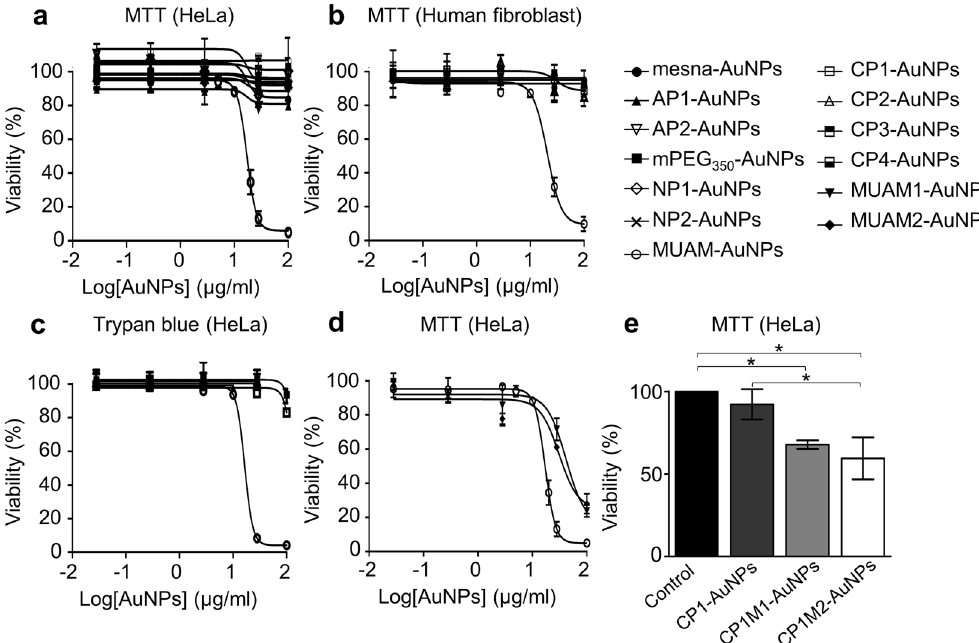
Figure 2. Effect of modified gold nanoparticles (AuNPs) on cell viability. ( a ) The viability of AuNPs-treated HeLa cells were analysed using MTT assays. Only MUAM-AuNPs induced cell death with LD 50 of 17.1 μ g/ml. ( b ) The viability of AuNPs-treated human fibroblasts were analysed using MTT assays. Only MUAM-AuNPs induced cell death with LD 50 of 20.5 μ g/ml. ( c ) A trypan blue assay was performed on HeLa cells treated with modified AuNPs for 24 h. Only MUAM-AuNPs induced cell death with LD 50 of 16.5 μ g/ml. ( d ) MTT viability assay was performed on cells treated with three different MUAM-carrying AuNPs (MUAM-, MUAM1- and MUAM2-AuNPs). All three AuNPs showed comparable cytotoxicity regardless of ligand densities or the magnitude of positive charges. ( e ) MTT viability assay was performed on Cells treated with three different CP1-derived AuNPs (CP1-, CP1M1- and CP1M2-AuNPs). The introduction of hydrophobic chains increased cytotoxicity of CP1-derived AuNPs. The results are shown as mean ± standard error of mean ( * p < 0.05 , one- way